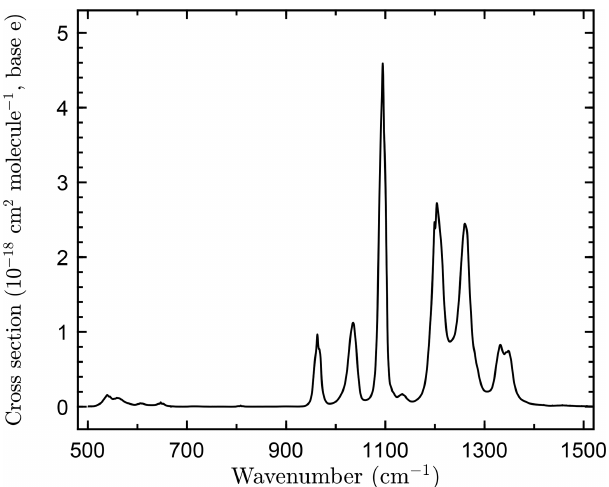
Figure 1. Infrared absorption spectrum of octafluorooxolane ( c - C 4 F 8 O) measured in this work at 296K at 1cm − 1